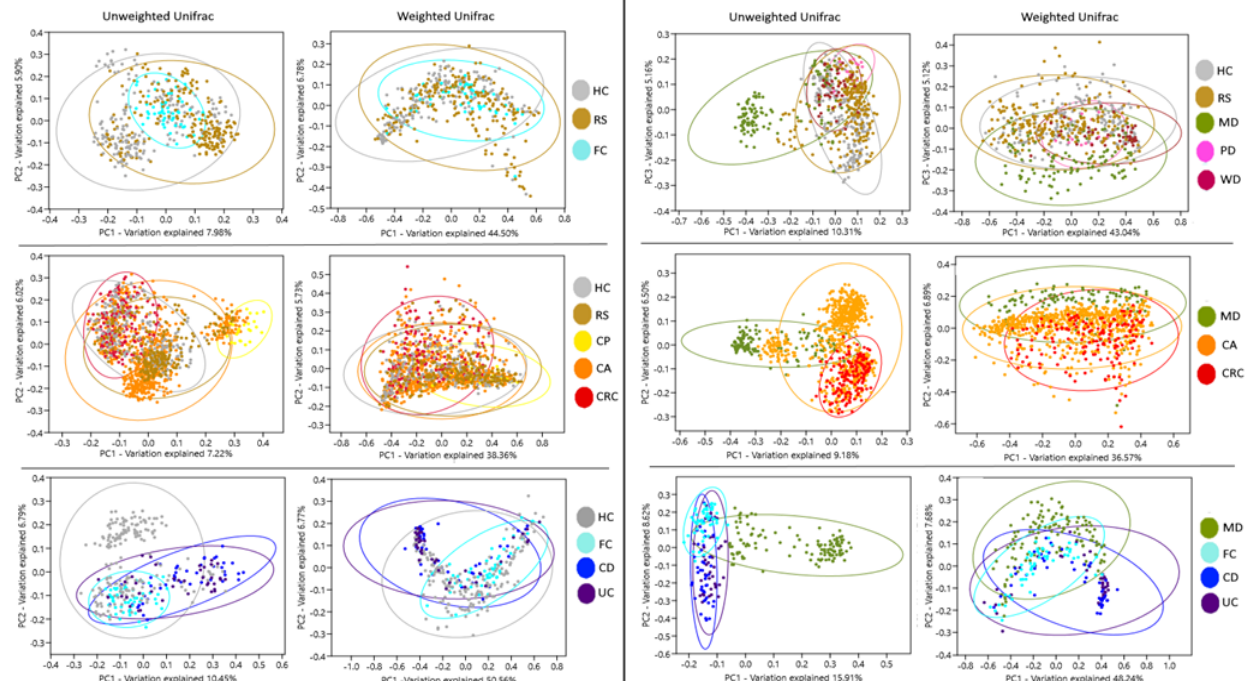
Figure 1. Analysis of bacteria community components. Principal coordinates analysis of Unifrac distances for the different groups. Ellipses indicate 95% confidence intervals. Groups: Healthy subjects (HC), subjects at risk of developing colorectal cancer (RS), healthy familiars of IBD patients (FC). Patients with colon polyps (CP), colon adenoma (CA), colorectal cancer (CRC), Crohn’s disease (CD), and ulcerative colitis (UC). Subjects following a Mediterranean (MD), modern Paleolithic (PD), or Western-like diet (WD). Table 2. Average OTU composition (%) of the different groups at phylum level. Phylum 1 HC RS FC